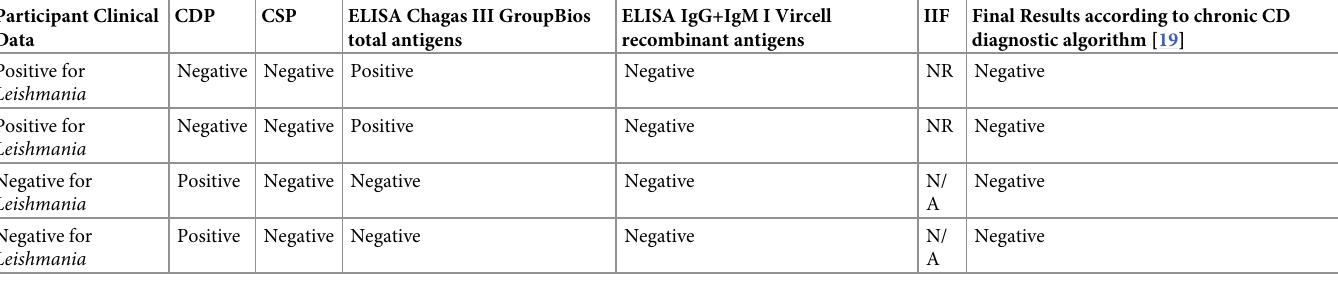
Table 2. Discordant results obtained from EC tests in patients from the department of Boyaca´. Participant Clinical Data